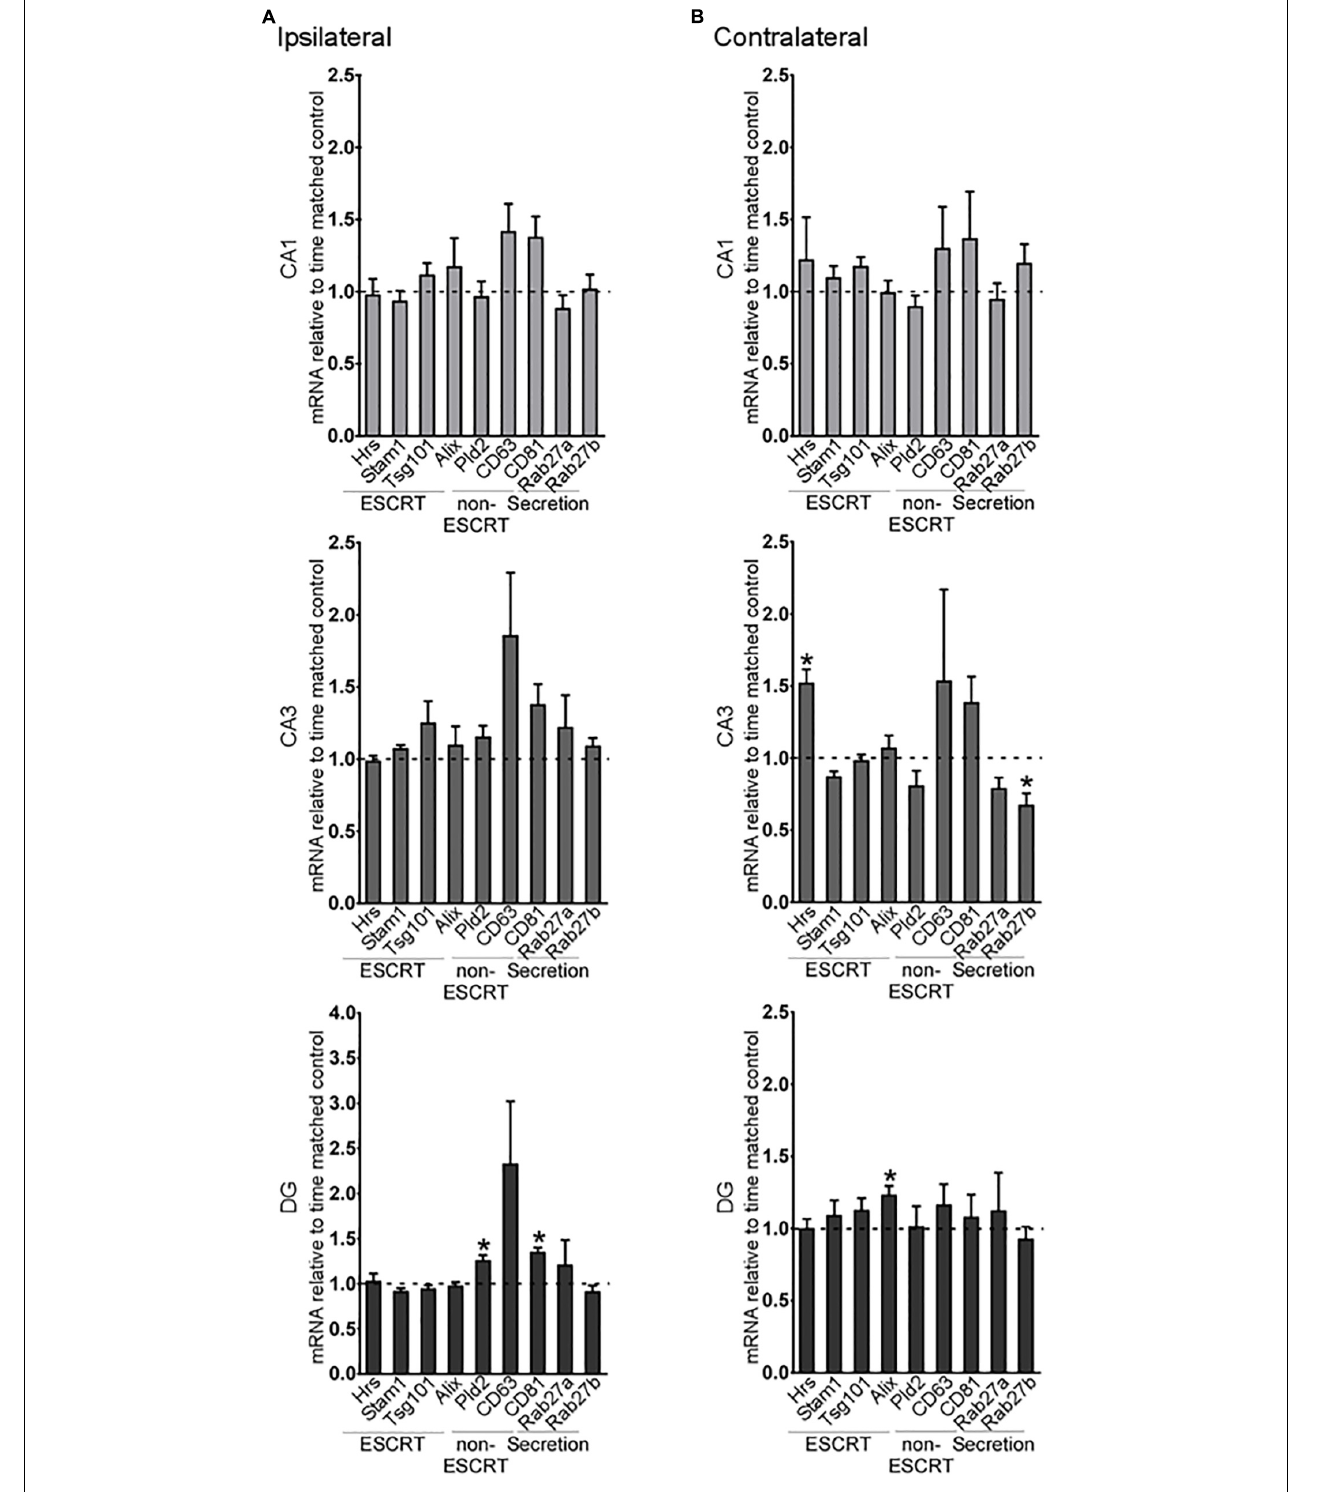
FIGURE 3 | Long-term regulation of exosome biogenesis transcripts in hippocampal subfields after status epilepticus. Graphs show mRNA levels of exosome pathway components in samples obtained 2 weeks after SE for each subfield in the (A) ipsilateral and (B) contralateral hippocampus. Transcript levels were normalized to β -actin . Graphs show mean ± SEM. n = 5 per group. ∗ p < 0.05, t -test comparing to control.